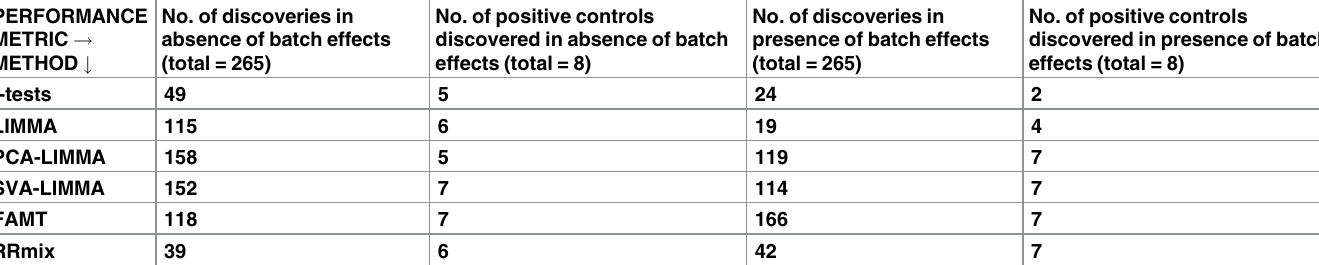
Table 1. Summaryresults of differential abundance analysesusing various